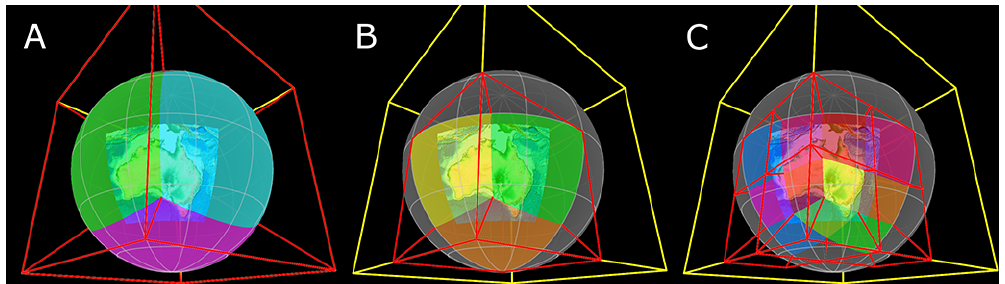
Figure 6. The cube map tiles (highlighted in different colours) of a regional raster at three different resolution levels. Since the raster is regional, not all cube map tiles are required – only those that actually cover the raster’s region. This highlights the partial nature of quadtrees of regional rasters. (A) Only three cube faces (and hence three quadtrees) are required to provide coverage of the regional raster at quadtree level 0. (B) For each of the three cube face tiles in (A) only one of four possible child tiles (quadtree level 1) are required to cover the raster.